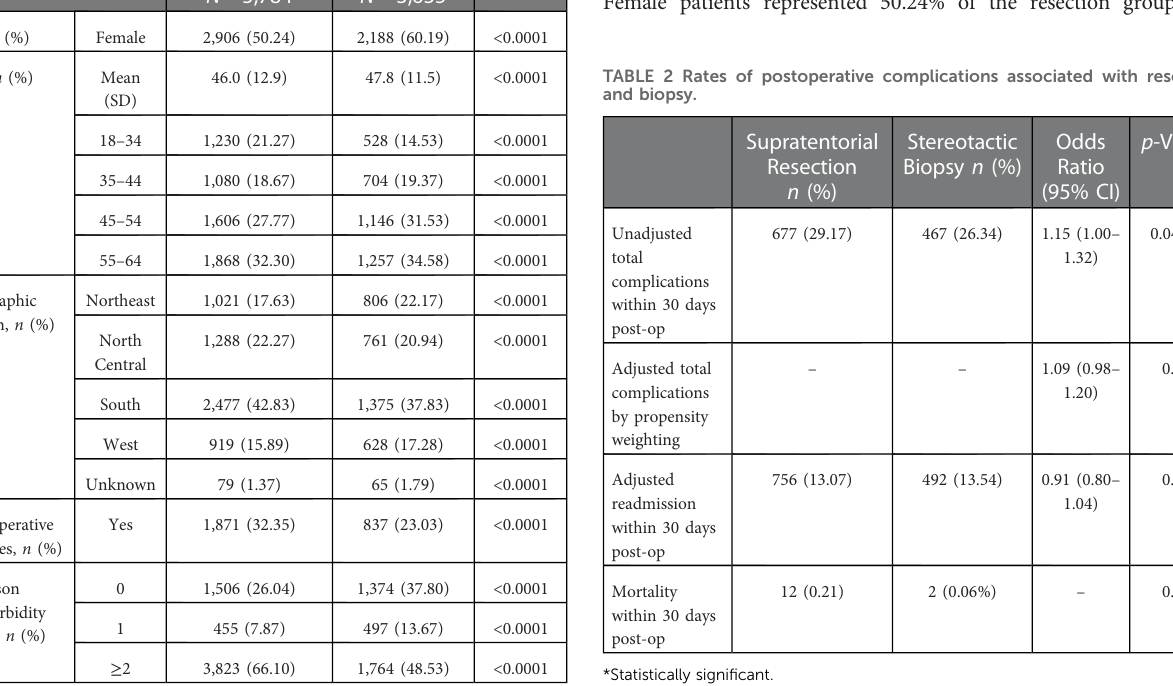
TABLE 1 Low-Grade Glioma Patient Characteristics in Total Cohort, Strati fi ed by Procedure (2005 – 2014). Patient